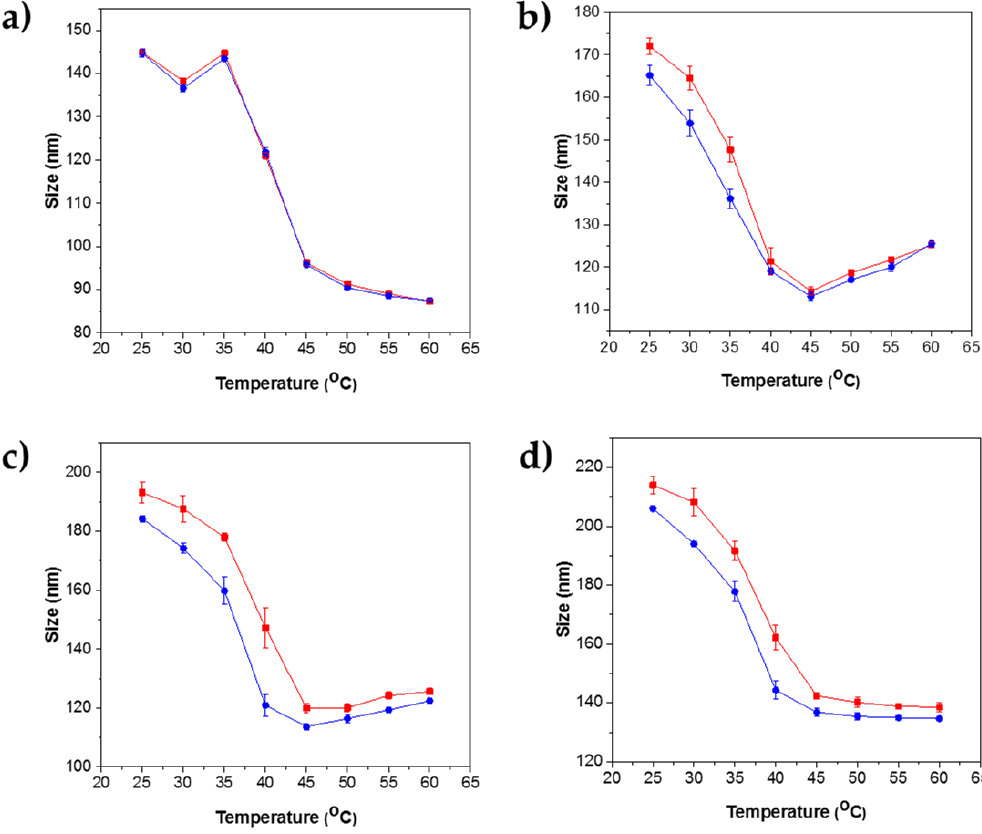
Figure 4. Variations in the hydrodynamic sizes of nanogels as a function of temperature measured using DLS. The red bars indicate heating, and the blue bars indicate cooling. ( a ) Nanogels with PEGDMA ( M n 200 g/mol). ( b ) Nanogels with PEGDMA ( M n 400 g/mol). ( c ) Nanogels with PEGDMA ( M n 550